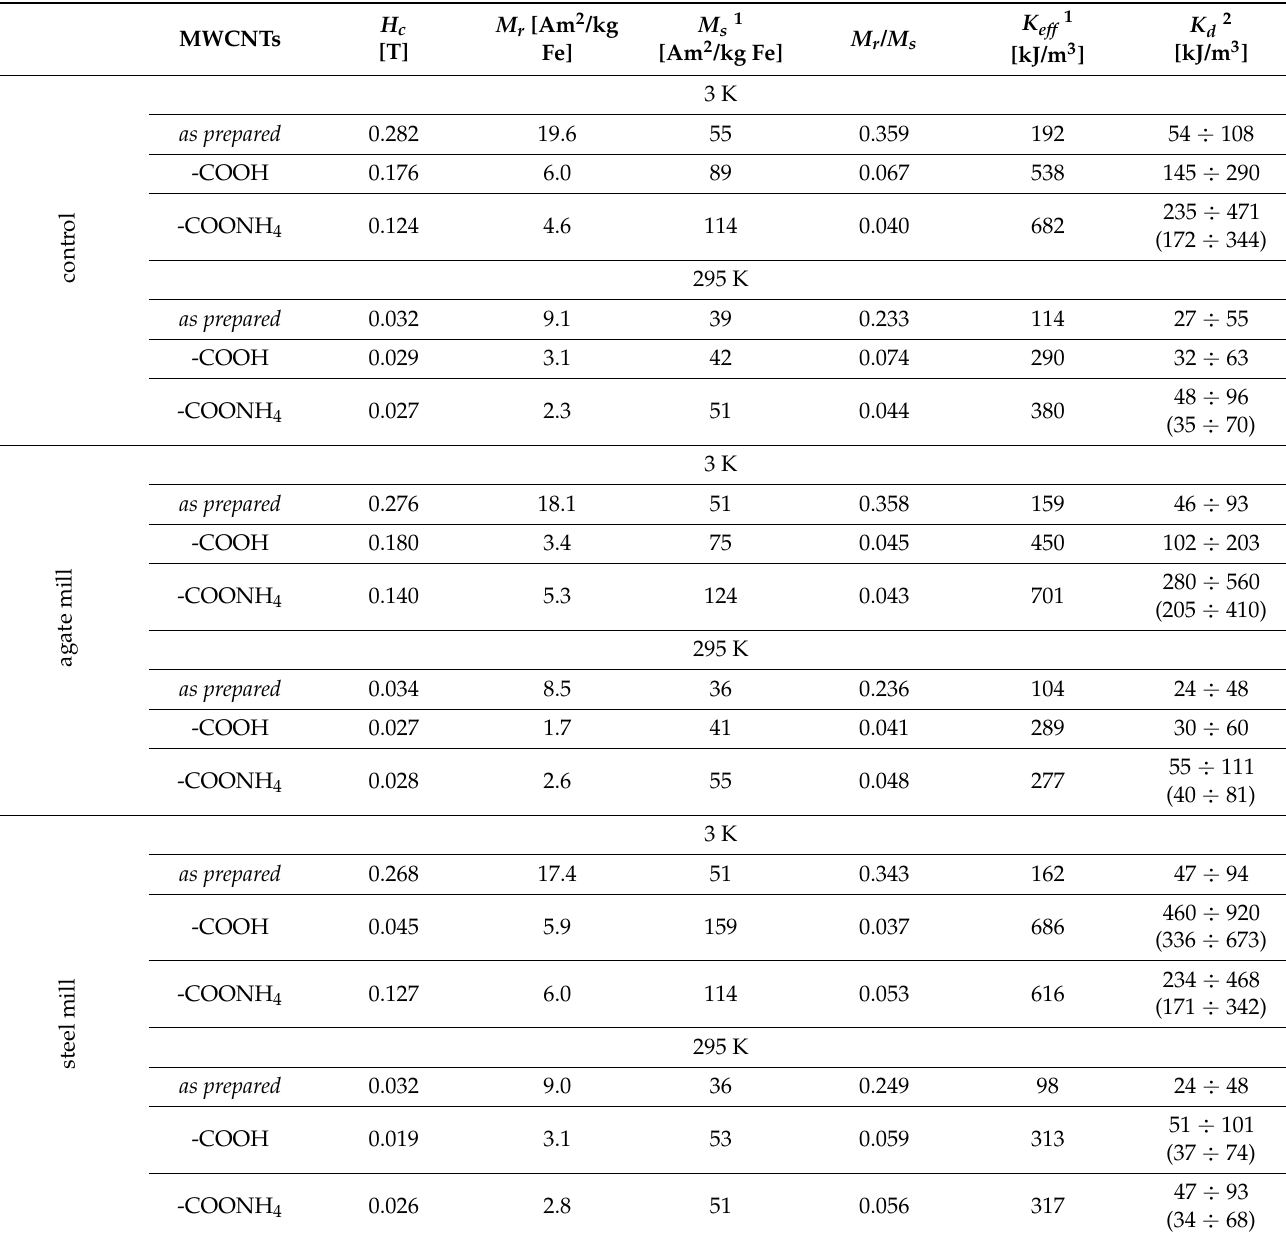
Table 2. Coercive and remanent fields ( H c and M r ), saturation magnetization ( M S ), effective anisotropy constant ( K eff ), and shape anisotropy constant ( K d ) for as prepared MWCNTs, MWCNTs-COOH, and MWCNTs-COONH 4 unground and ground in the agate and steel mill.